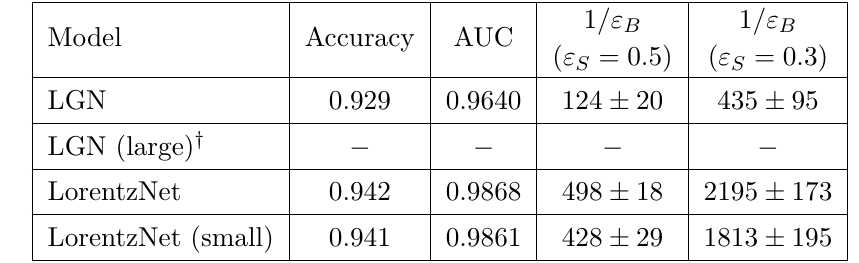
Table 7 . Performance comparison between LorentzNet and LGN on top tagging dataset. The results for LorentzNet are averaged on 6 runs. The results for LGN are referred to [61]. † We do not evaluate this model since it takes too long to